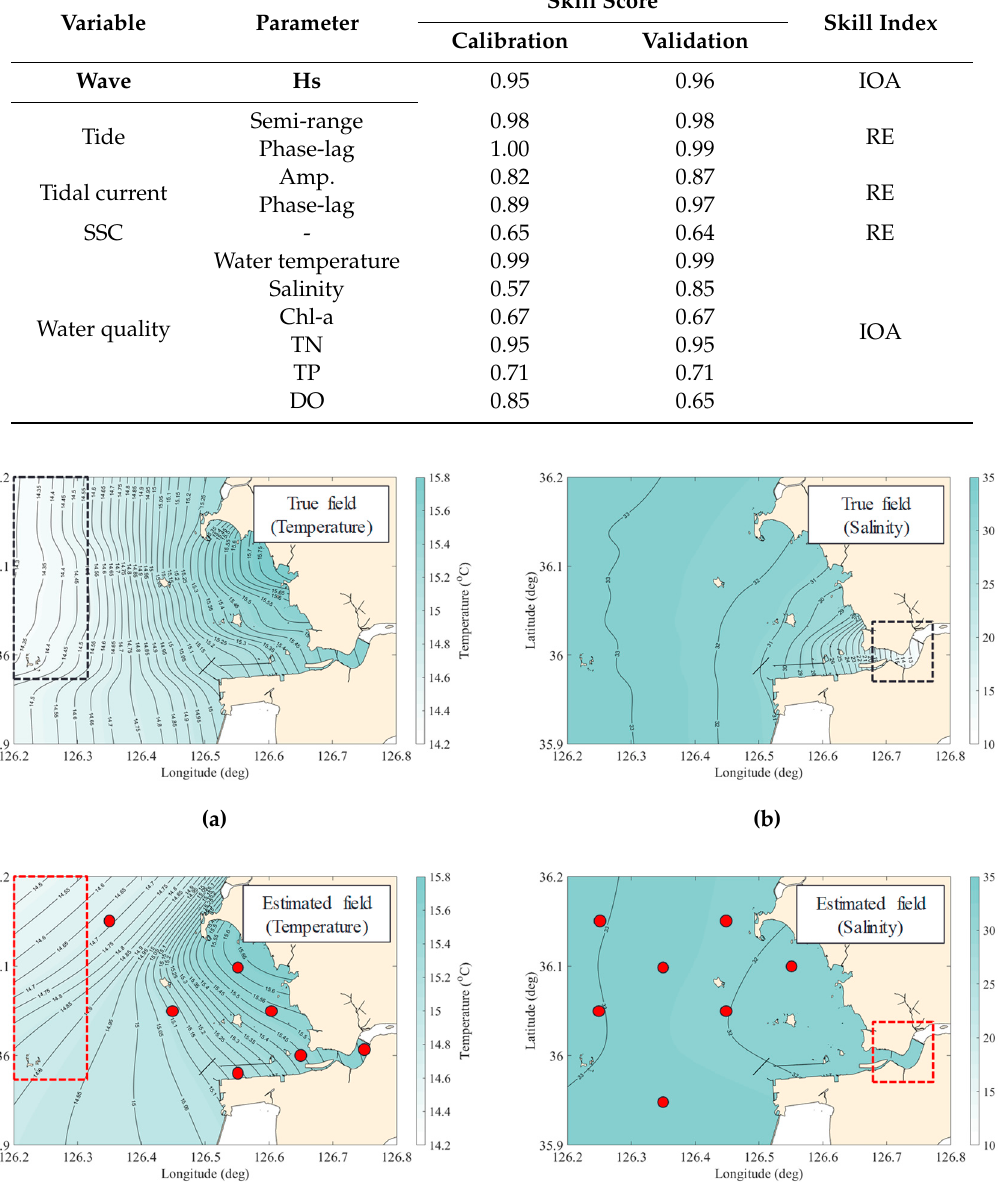
Table A2. Calibration and validation of the numerical model [19]. The abbreviation of “SSC”, “Hs”, and “Amp” imply the suspended sediment concentration, significant wave height, and amplitude, respectively.